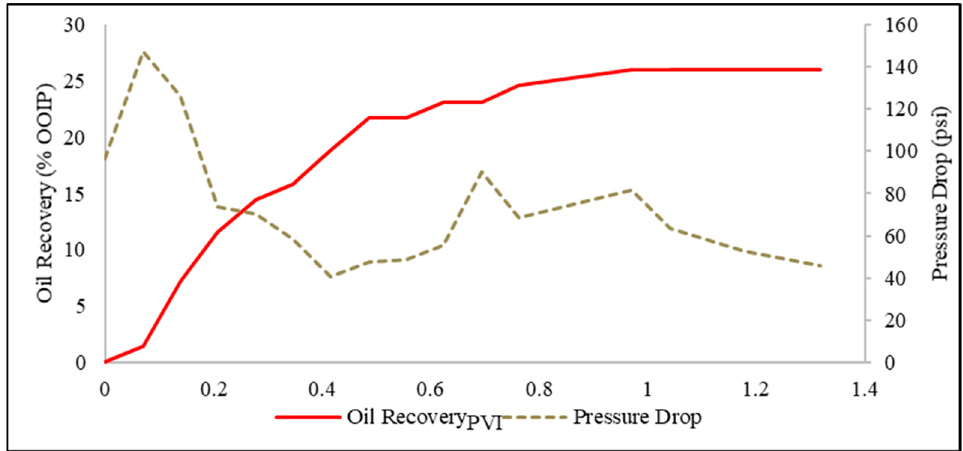
Figure 15. Oil recovery and pressure response for Clinton sandstone miscible CO 2 flood.